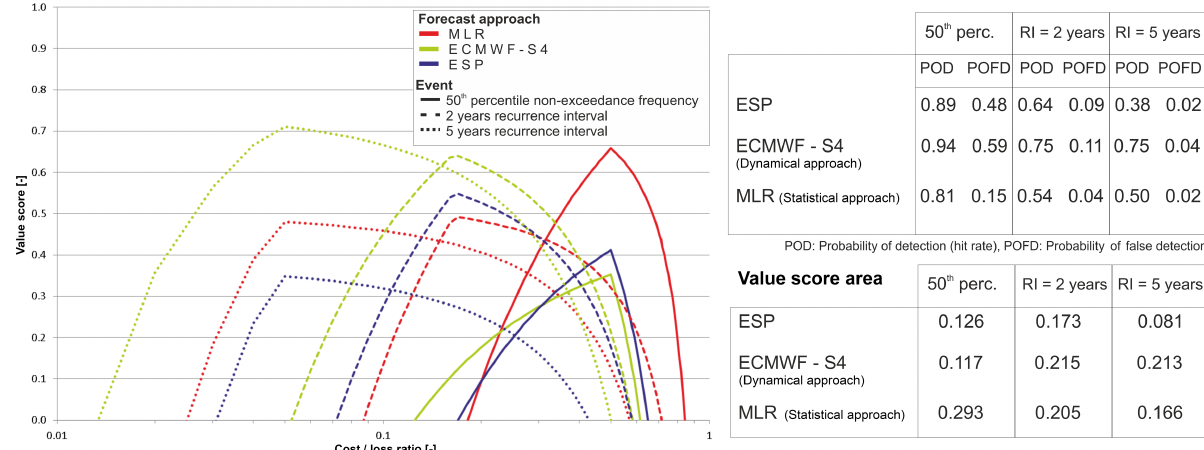
Figure 9. Economic value score plotted against cost/loss ratio for three forecast approaches predicting the lowest 7-day mean MoNM 7 Q of the current month at the gauge Kaub/Rhine for three different event thresholds within the typical low-flow season of July to November (verification period